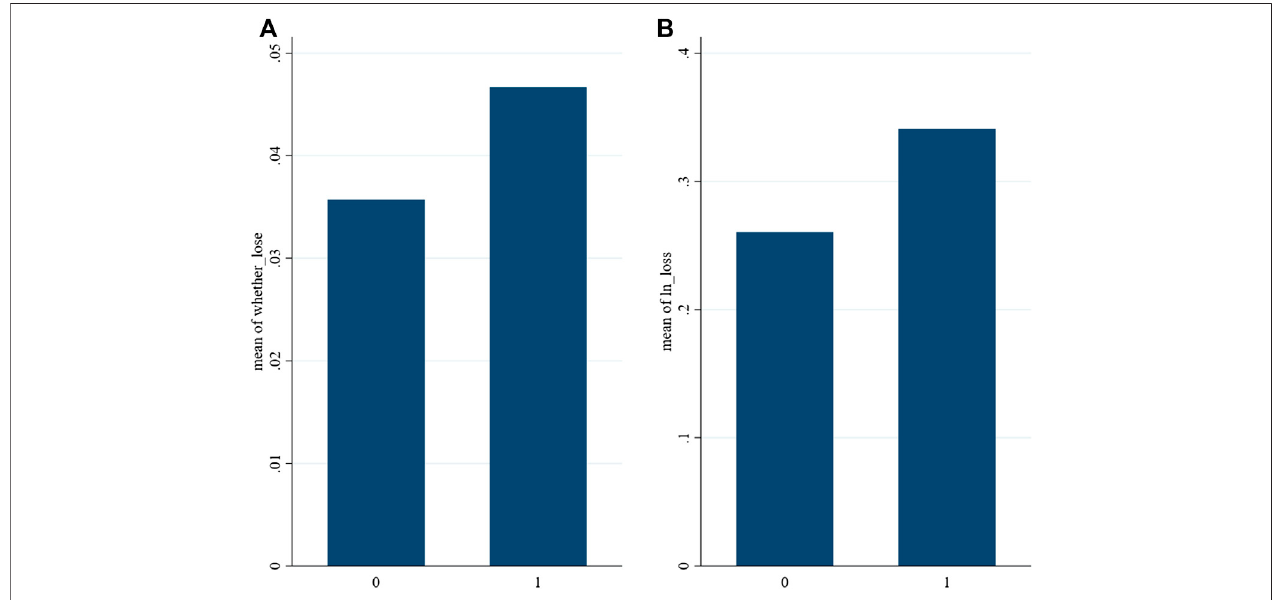
FIGURE1| Theaverageoftheprobabilityofbeingdefrauded (A) andtheaveragelogamountofbeingdefrauded (B) forurbanresidents(Migrant=0)andmigrants (Migrant = 1).